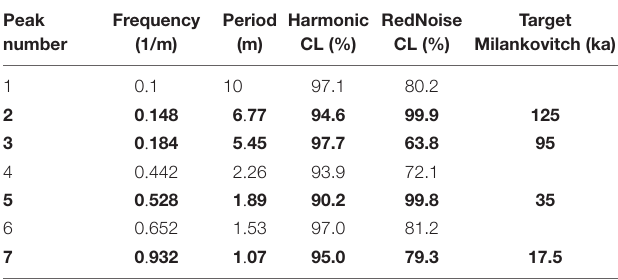
TABLE 1 | Portable SM-20 spectral peaks.